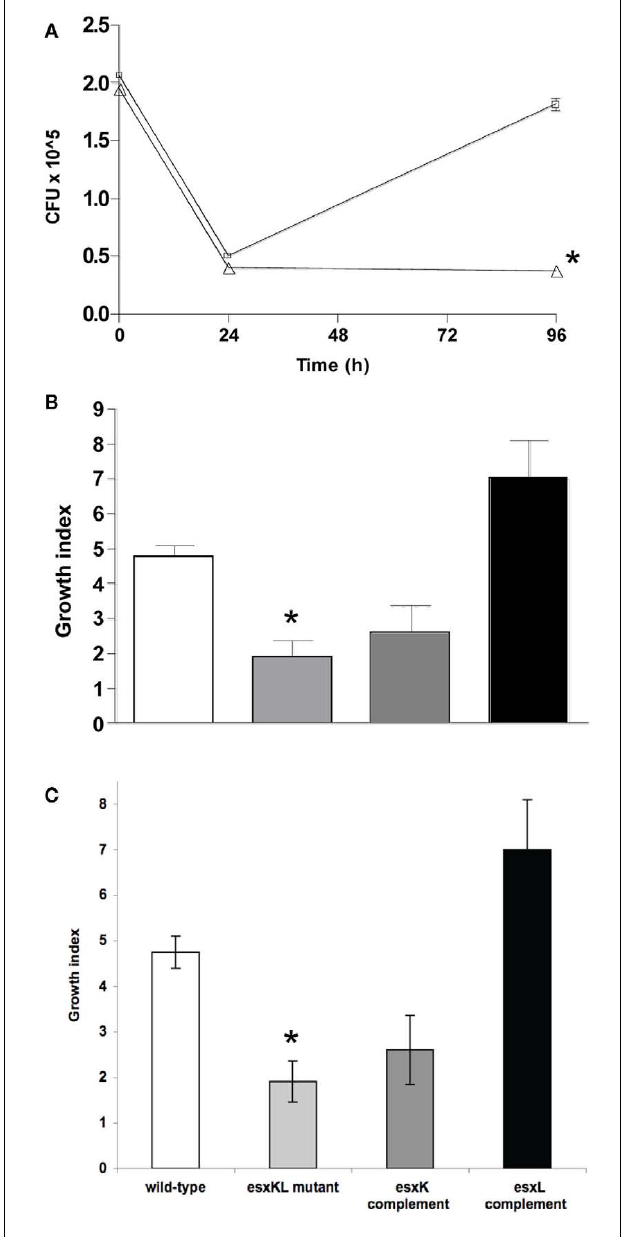
FIGURE 2 | Δ esxKL mutant is defective in intracellular growth. (A) THP-1 cells were infected with wild-type (open squares) or Δ esxKL mutant (open triangles) at a MOI of 1: l. Data points indicate the mean number of CFUs for three independently infected wells and error bars indicate SD from means. Intracellular growth of the Δ esxKL mutant was significantly reduced in three independent experiments ( P < 0.005)* at 96h as determined by unpaired t -test. (B) THP-1 cells were infected at MOI of 1:1 and a growth index as CFU at 96h relative to CFU at 24h was determined for wild-type (open bar), Δ esxKL (light gray bar), esxK complemented (dark gray bar), and esxL complemented (black bar) strains. Reduced intracellular growth of Δ esxKL ( P < 0.005)* was reversed by restoring only esxL . Data shown is a representative of two independent experiments. (C) The Δ esxKL mutant showed this growth defect in similar experiments with a primary single-donor PBMC infection model, and restoring esxL allowed normal intracellular